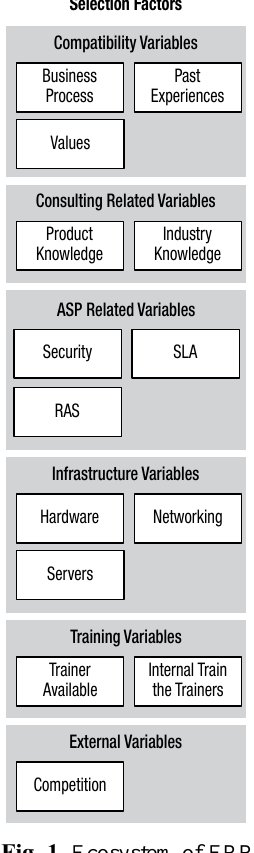
Fig. 1. Ecosystem of ERP implementations (adopted